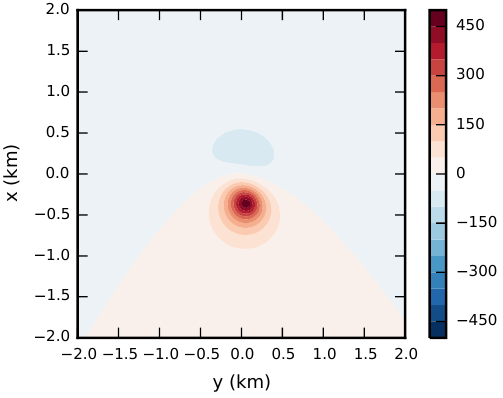
Figure 5. Total-field anomaly (in nT) produced by the synthetic ore- body defined in Table 2. The synthetic data are calculated on a reg- ular grid of 100 × 100 points at the constant vertical coordinate z =